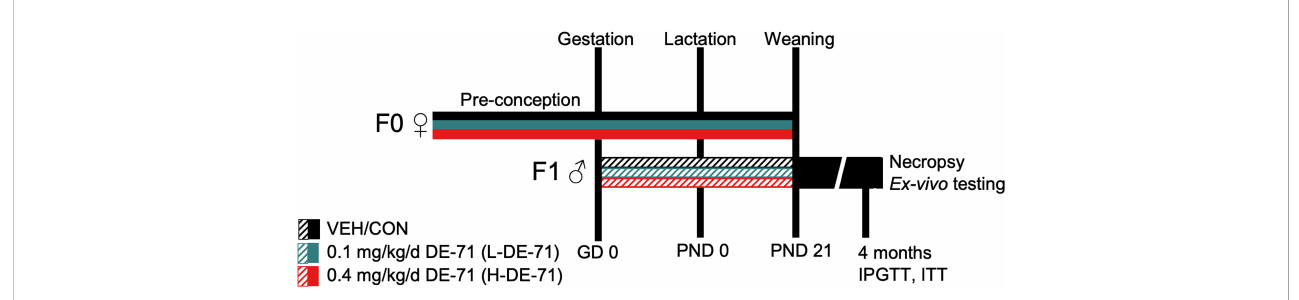
FIGURE 1 Diagram depicting the dosing and testing paradigm used for perinatal exposure to DE-71. Direct exposure of dams to DE-71 (F0 ♀ , solid shading), began ~4 weeks pre-conception and continued daily through ~3 weeks of gestation and 3 weeks of lactation until pup weaning at PND 21. Indirect exposure to DE-71 in male offspring (F1 ♂ , hatched shading) occurred during the prenatal (GD 0- 20) and postnatal periods (PND0-PND21) via lactation. Offspring received 39 days of DE-71 exposure during the prenatal period except on PND 0 and 1. Metabolic endpoints (fasting glycemia, GTT, ITT) were examined in Cohort 1 offspring at ~4 months of age. Another cohort (Cohort 2) of animals was raised for ex vivo analyses. At necropsy (~4 mo of age) Cohort 2 body and organ weights were recorded and blood and organ tissues collected for further analysis: plasma hormones, UPLC/MS/MS detection of endocannabinoids, adrenal epinephrine and liver GDH enzymatic activity. GD, gestational day; PND, postnatal day; GDH, glutamate